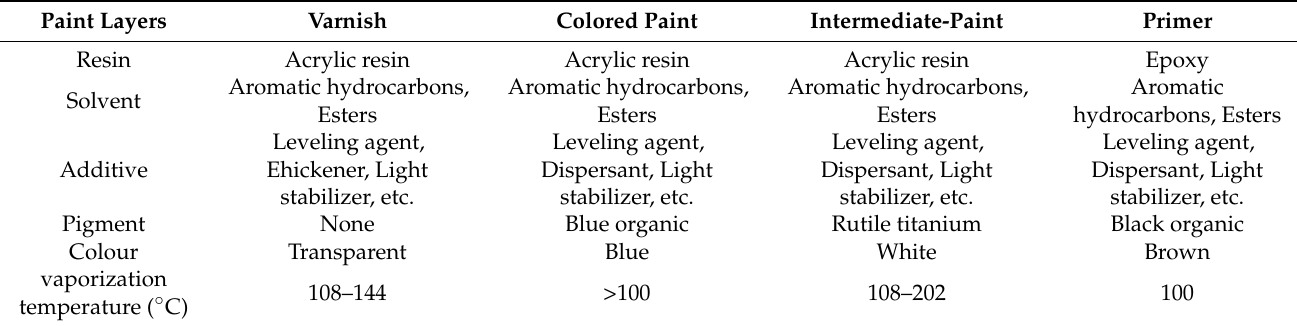
Table 1. Components and physical properties of paint